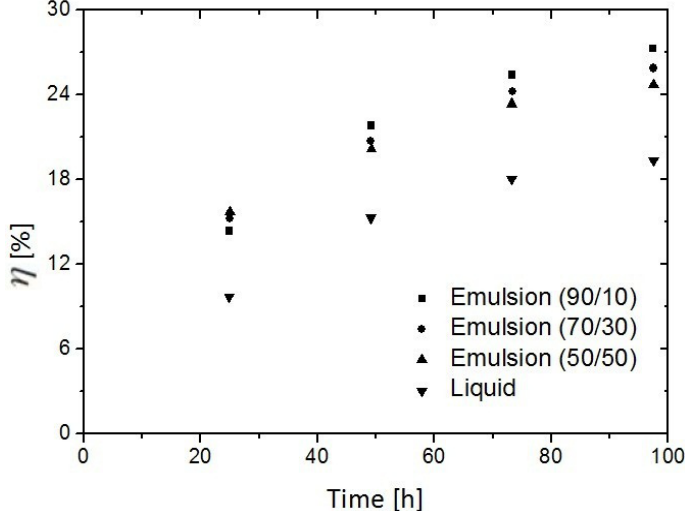
ratios replaced from the hydrate with different forms of CO Figure 9. CH 4